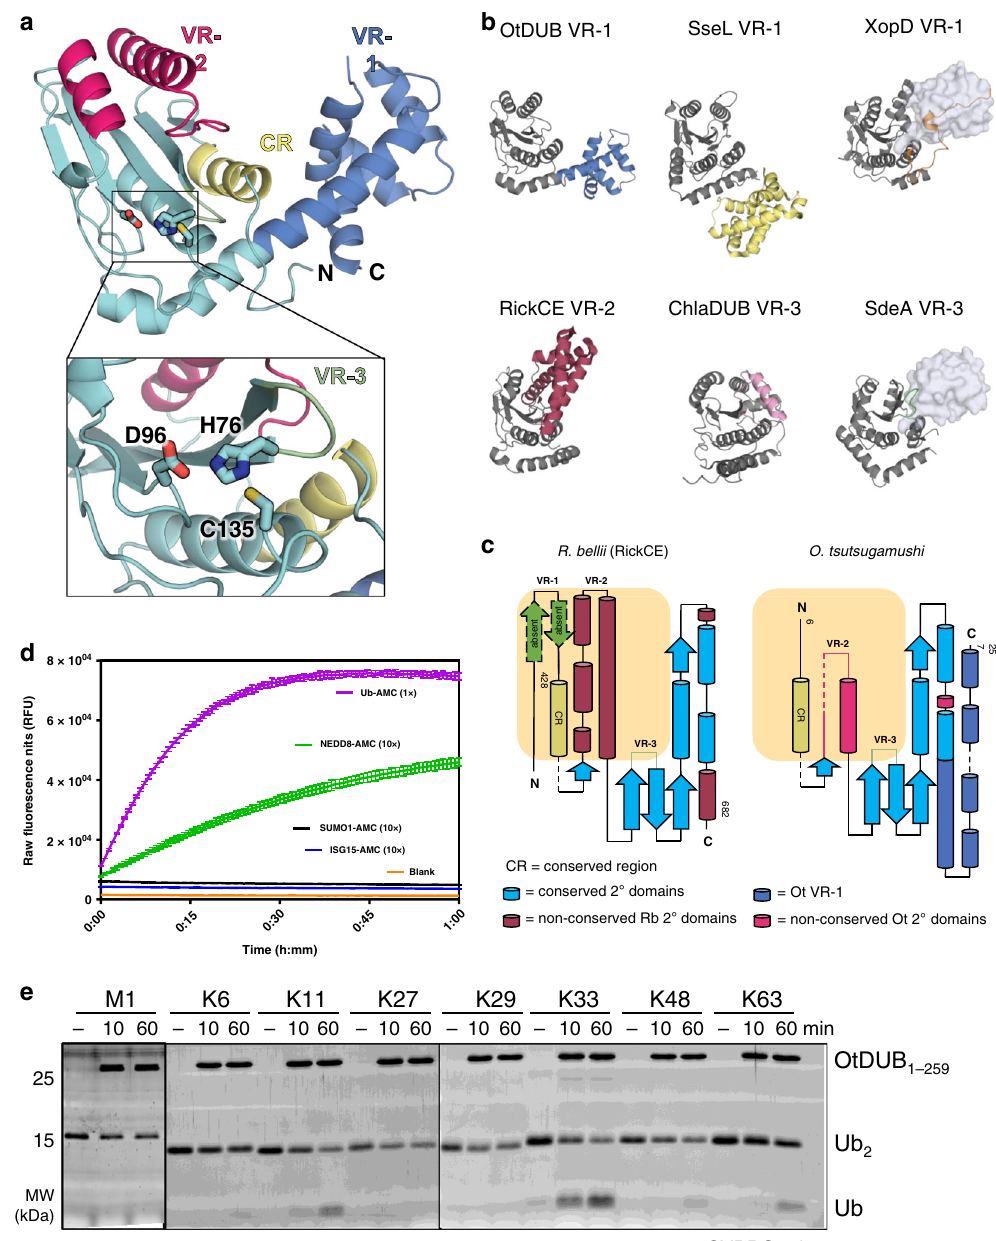
Fig. 1 The OTT_1962 (OtDUB) Ulp1-like domain is a deubiquitylase. a Crystal structure of OtDUB 1 – 259 , with residues 6 – 257 modeled. The deubiquitylase (DUB) domain is in cyan, the proposed variable region 1 (VR-1) in slate blue, conserved region (CR) in yellow, VR-2 in magenta, and VR-3 in green (inset: Cys protease catalytic triad). b Structural comparison of variable regions among bacterial CE-clan DUBs (conserved catalytic fold in gray): OtDUB 1 – 259 VR-1 (slate blue), SseL VR-1 (yellow, PDB ID: 5HAF), XopD VR-1 (orange, PDB ID: 5JP3), RickCE VR-2 (rose, PDB ID: 5HAM), ChlaDUB1 VR-3 (violet, PDB ID: 5HAG), and SdeA VR-3 (green, PDB ID: 5CRB). S1-bound ubiquitin is shown as transparent surface where applicable. c Secondary structure maps of OtDUB 1 – 259 and the closely related DUB domain from R. bellii . α -Helices are represented as cylinders, and β -sheets represented as arrows. Boxed region (orange) denotes previously characterized CE-clan VRs. Structurally conserved region (CR; yellow) and VR-3 (green) are denoted. d Cleavage assays of Ub- and Ubl-AMC (400 nM) incubated with OtDUB 1 – 259 at 350 pM for Ub-AMC (1×) or 3.5 nM for Ubl-AMC (10×). Lines represent the mean of a technical triplicate with SD error bars at each 40-s time interval. e Representative gels for an in vitro cleavage assay using di-ubiquitin substrates (1 µ M each) that were incubated in the presence or absence of OtDUB 1 – 259 (0.5 µ M) for the indicated times, resolved by SDS-PAGE, and stained with SYPRO Ruby ( n = 2). Black lines denote separate gels. Source data are provided as a Source Data fi seven lysine linkages and linear di-ubiquitin. OtDUB 1 – 259 could (Fig. 1d). It showed no activity toward the Ubls ISG15-AMC or SUMO1-AMC and weak activity toward NEDD8-AMC, similar cleave multiple chain linkages, including K6, K11, K33, K48, and to other bacterial CE-clan DUBs 11,15 . To determine if K63 (Fig. 1e). A preference was observed for K33-linked chains, a poorly studied linkage type associated with immune responses OtDUB 1 – 259 had any preferences for speci fi c ubiquitin-ubiquitin- chain linkages, we screened a di-ubiquitin panel, including all and secretory pathway traf fi cking 31 – 33 . Given the overwhelming